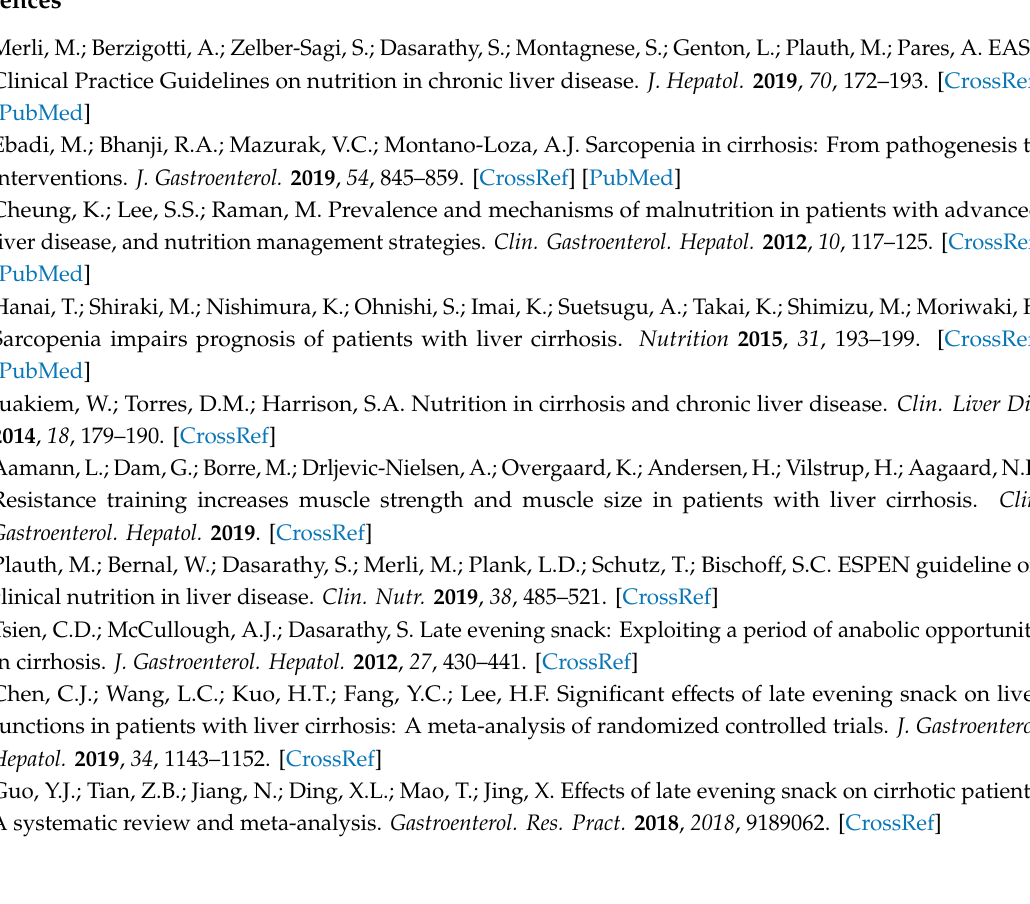
Figure S1: Standardized mean di ff erence used to compare the balance between the LES and No LES groups, Table S1: Causes of death before and after propensity score matching analysis, Table S2: Variables of the LES and No LES groups after inverse probability of treatment